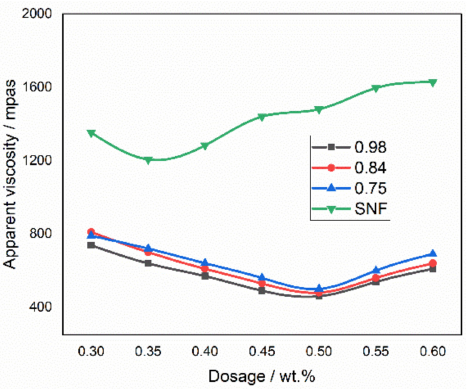
Figure 4. Effect of dispersant dosages on apparent viscosities at a shear rate of 100 s − 1 . As shown in the figure, with the different degrees of substitution (DS) of the sulfonic- cellulose succinate half ester (S-CSHE), the apparent viscosity decreases abruptly with increasing dispersant dosage, reaches a minimum and then increases above a certain dosage. The minimum viscosity corresponds to the optimal dispersant dosage (0.51 wt.%). Three factors could account for the viscosity increase above the optimal dispersant